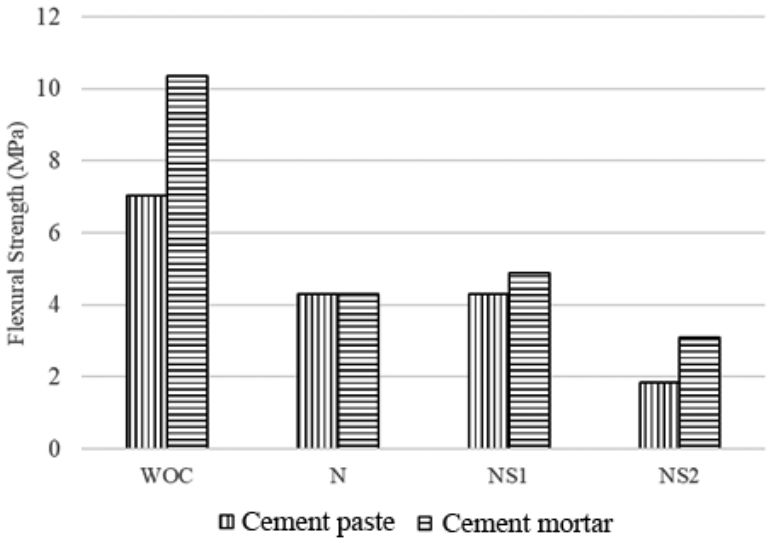
Figure 11. Flexural strength comparison between cement paste and mortars at crack initiation (after 7 days of curing, before self-healing). Samples without any capsules are designated as WOC.